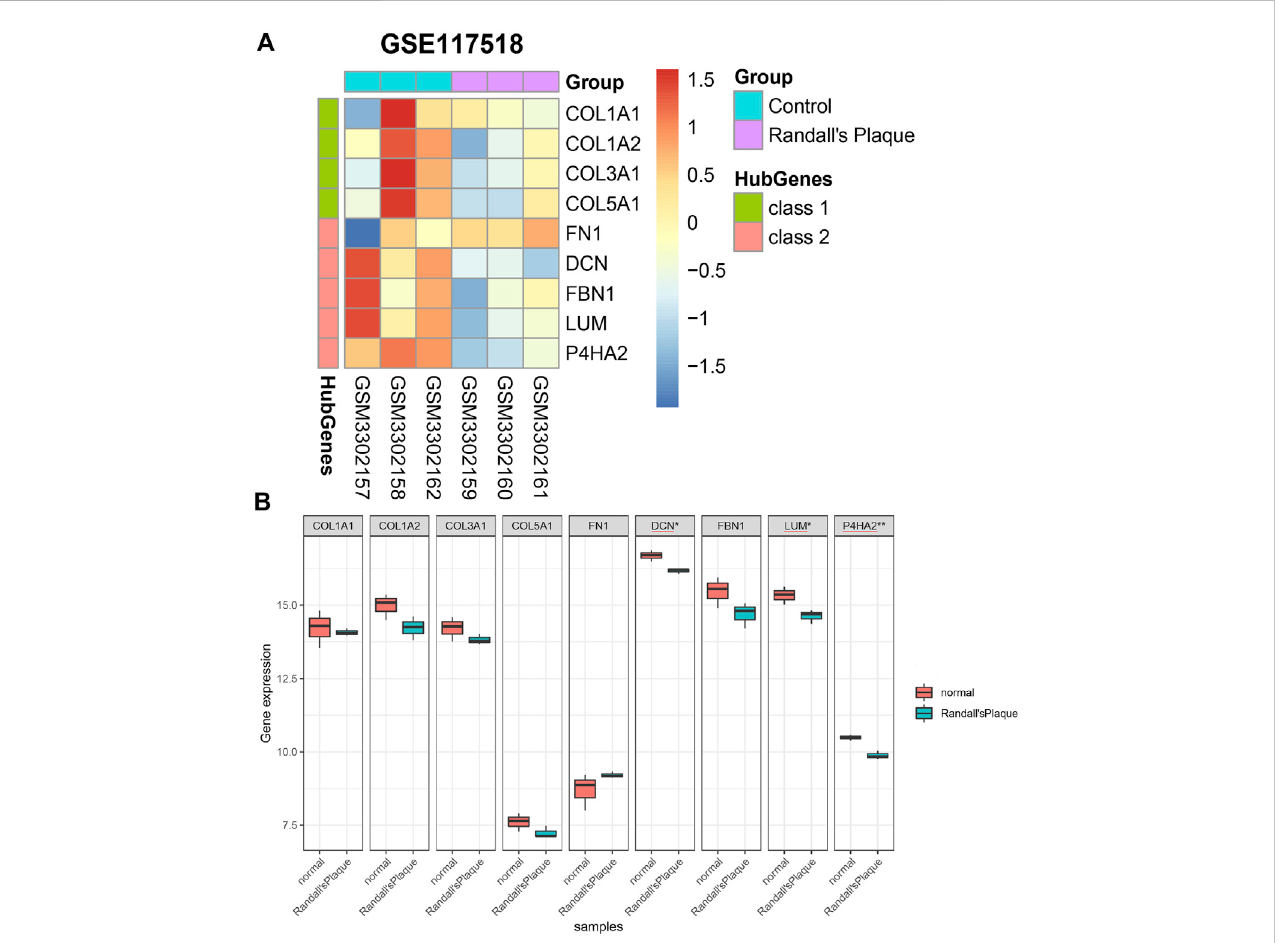
FIGURE 7 (A) Differential expression of nine hub genes in GSE117518. (B) Differential genes with signi fi cant differences between the normal and RP groups marked with